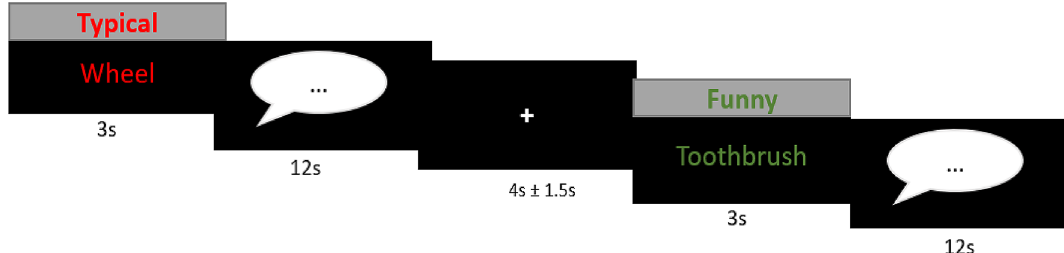
Figure 5. Experimental paradigm. During the task participants had to find either funny or typical usages for everyday objects (15 objects per condition). First participants were presented with the condition and word, afterwards they had to think aloud their idea. The ideas were recorded with a fMRI-suitable microphone and on-line